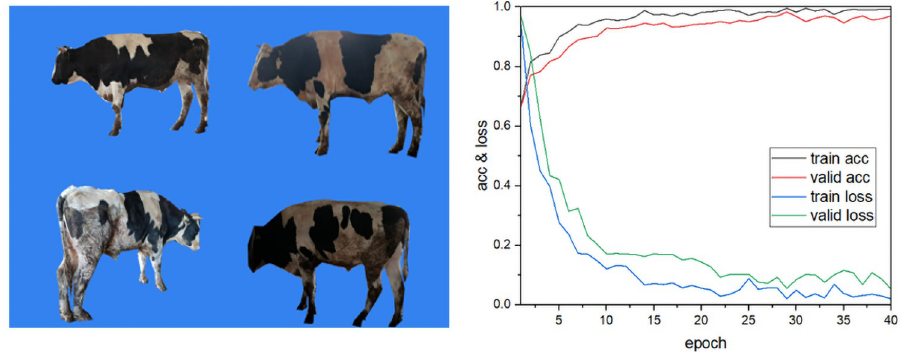
Fig 10. (a) Images of cows with a simple background, (b) accuracy and loss rate curves of the training model with the dataset with simple backgrounds.